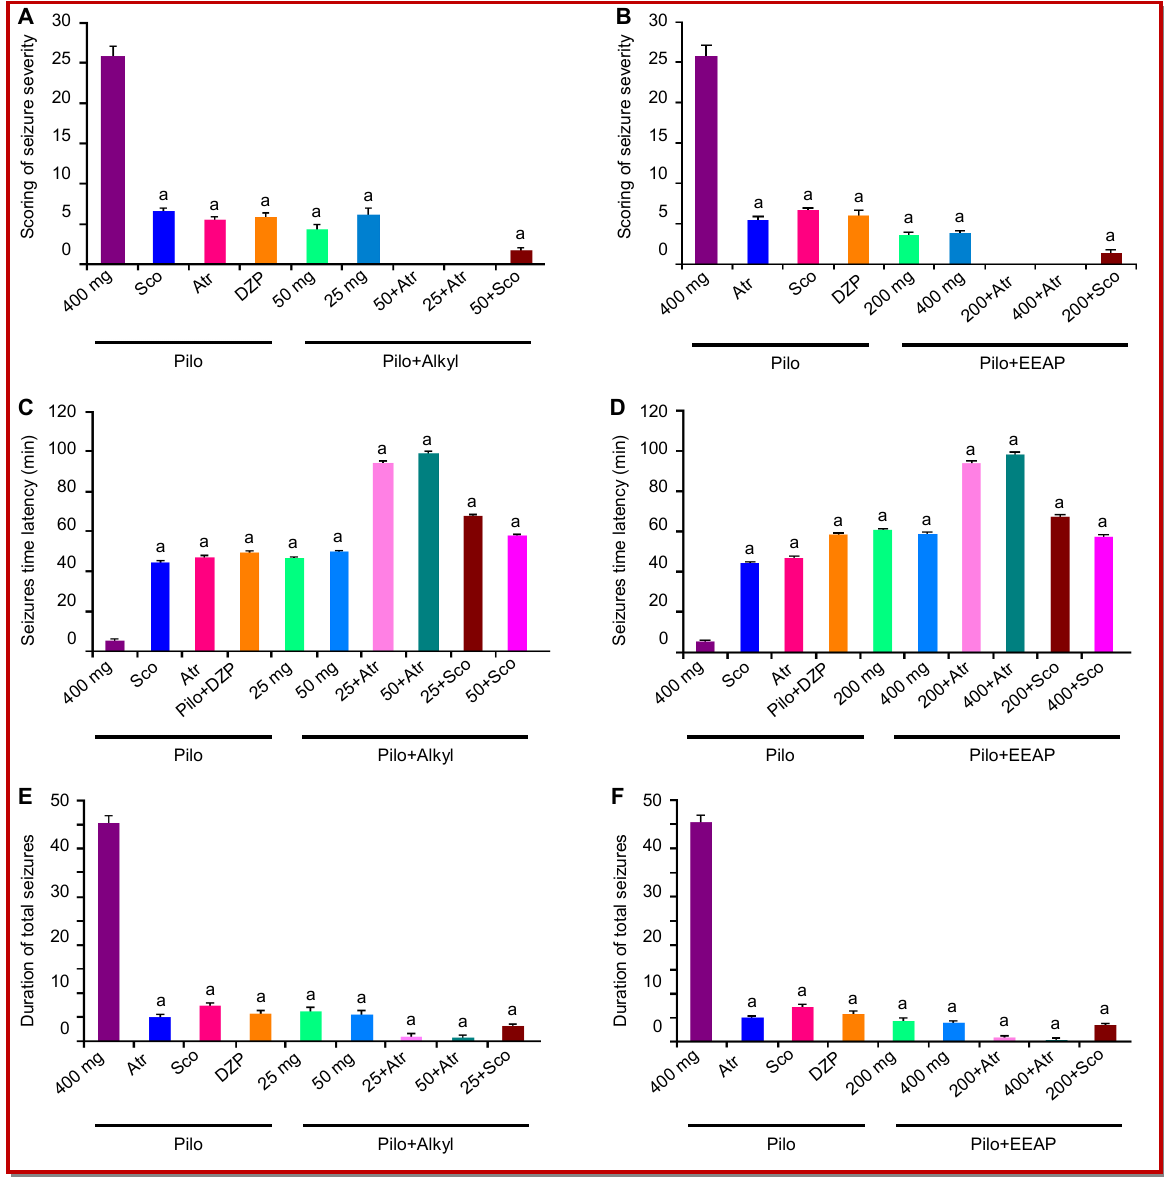
Figure 1: Total seizure scores (A,B), seizures time latency (C,D) and Duration of total seizures (E,F) of all the groups. Effect of treatment with EEAP (200, 400 mg/kg p.o), Alky (25, 50 mg/kg), (alky+scopolamine), (EEAP+ scopolamine), (alky+atropine), (EEAP+atropine) and, DZP on the pilocarpine induced convulsions. Results are expressed as means ± S.E.M.. (n = 6 per